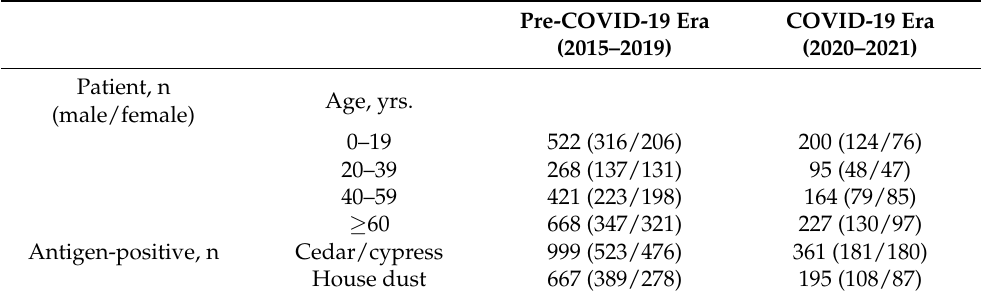
Table 1. Demographics of the study population, air pollutants, and pollen dispersion in Hi- roshima City.